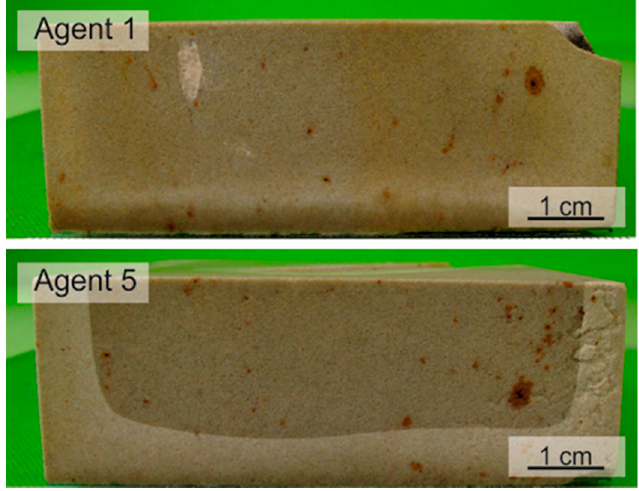
Figure 2. Visual penetration depth of agent No. and 5 after wetting the samples.